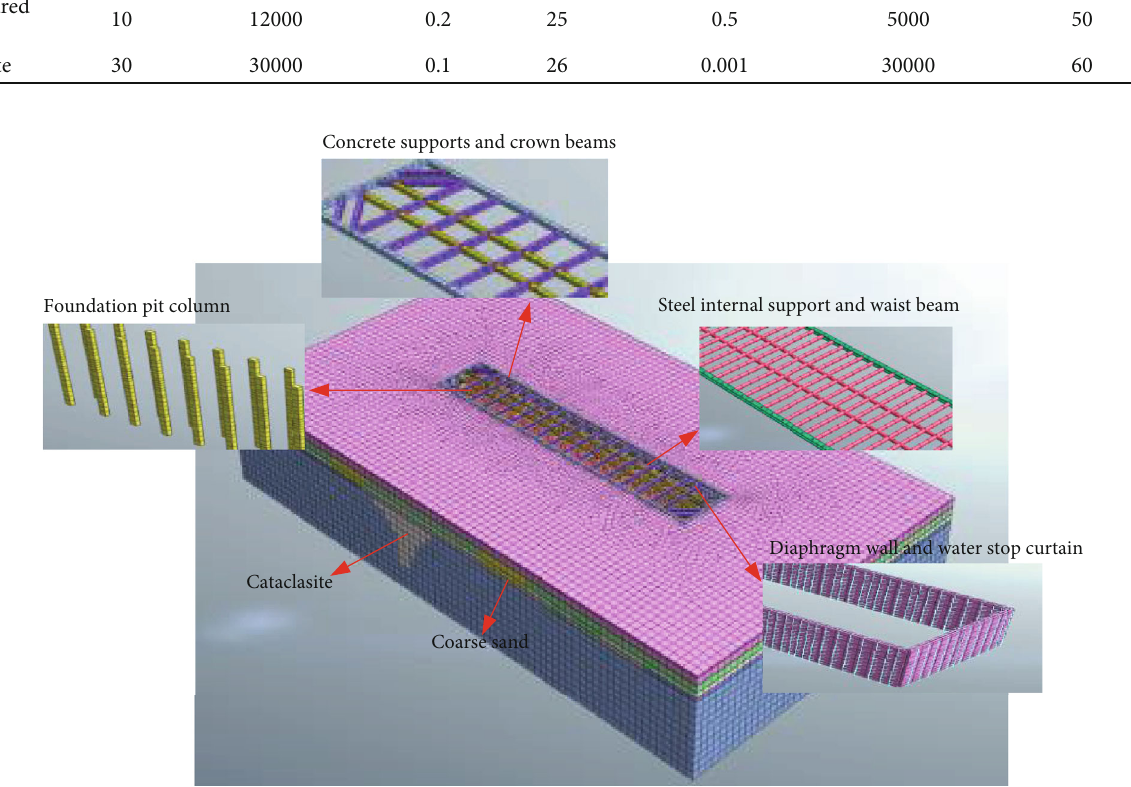
Figure 4: MIDAS/GTS numerical simulation